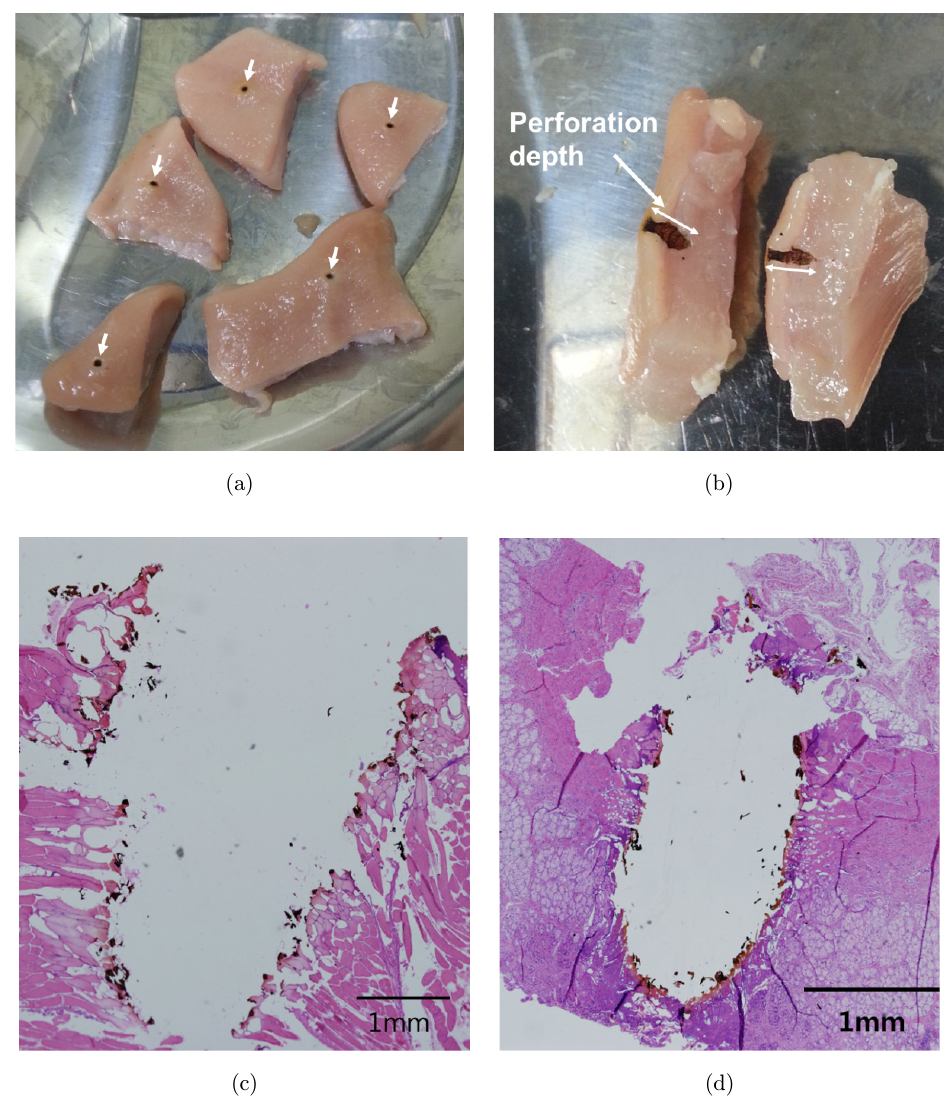
Fig. 2. (a) Perforated porcine tissue samples after laser irradiation. The black dot (indicated with a white arrow) in each tissue sample is the carbonized spot formed at the super¯cial layer. (b) Measurement of the perforation depth at the cross-section of the tissue sample. Microscopic hematoxylin and eosin-stained cross-sections of the (c) porcine ¯llet and (d) porcine stomach tissues. Figs. 2(c) and 2(d) for the perforated ¯llet and the stomach tissues, respectively.